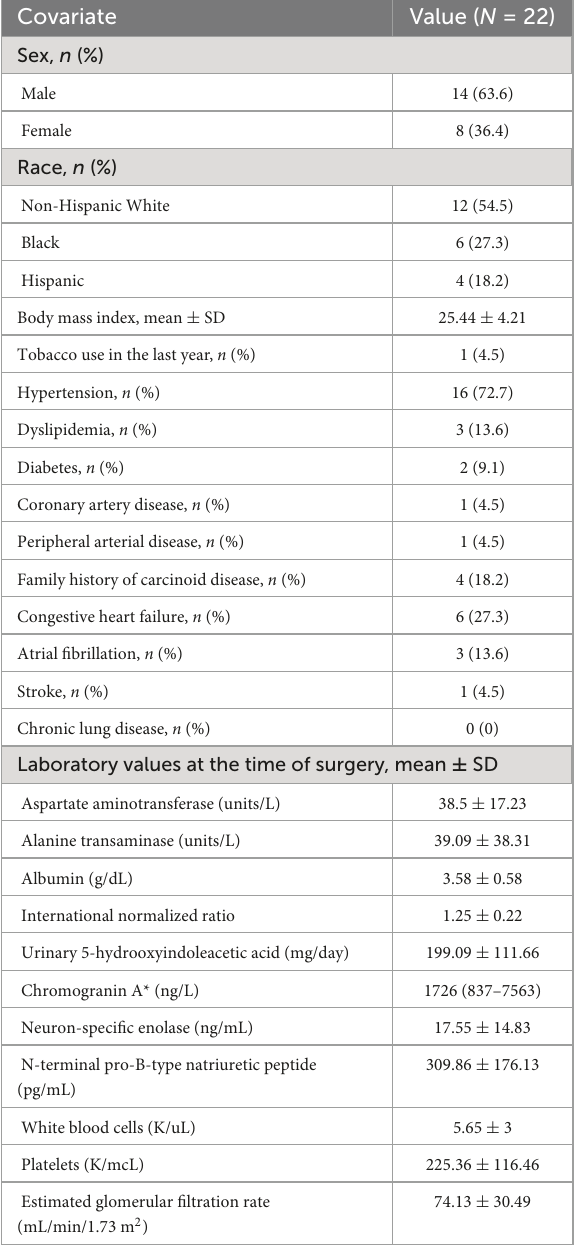
TABLE 1 Patients’ baseline